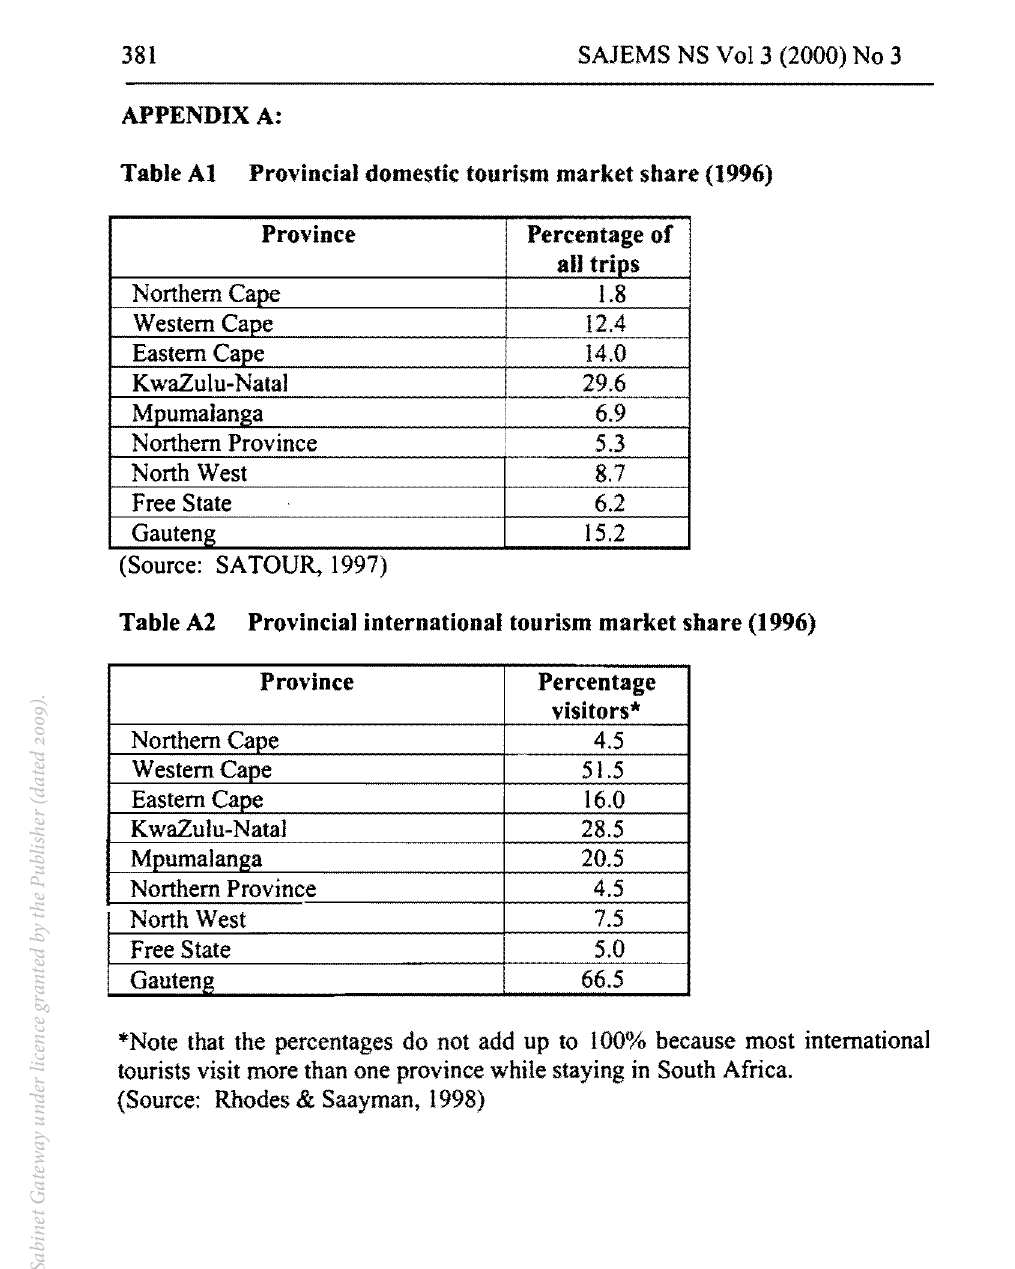
Provincial international tourism market share (1996) Province